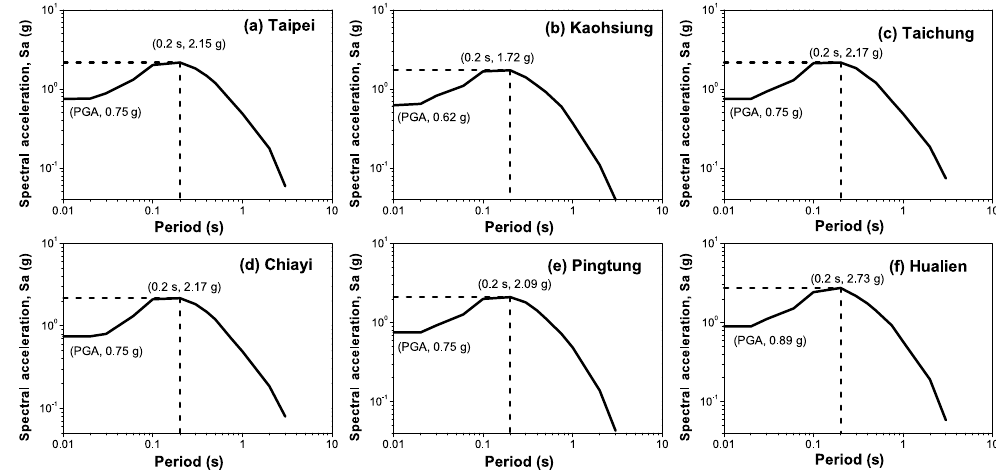
Figure 4. The response spectra for major cities in Taiwan with DSHA calculations.